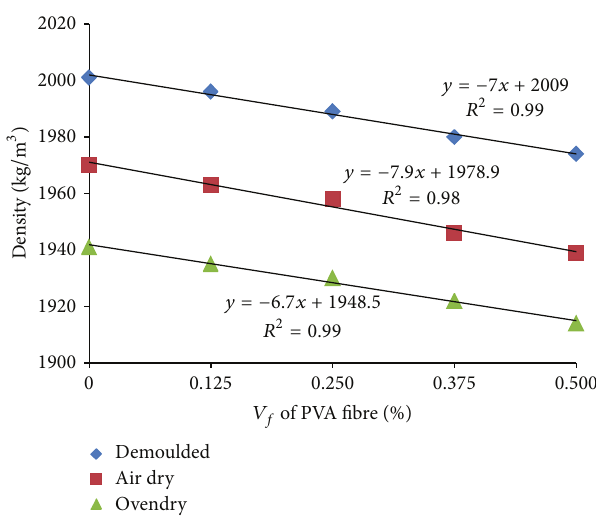
Figure 7: Relationship between PVA fiber volume fraction and